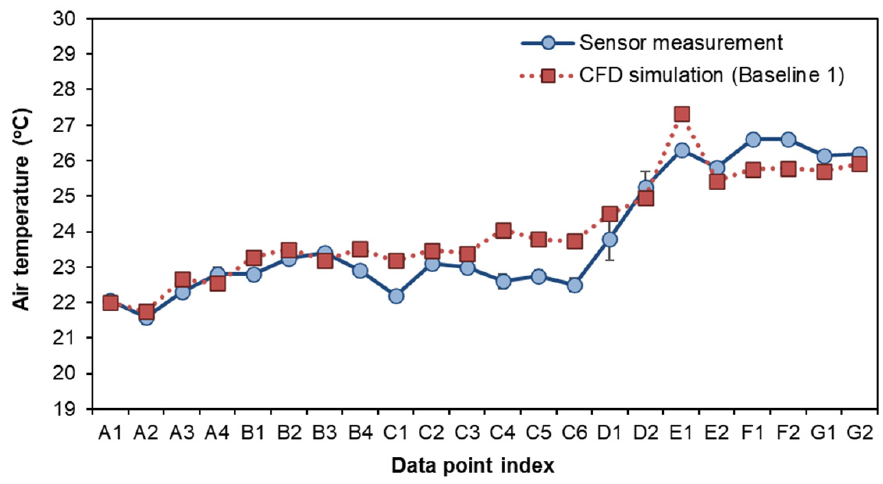
Figure 7. Comparison of indoor temperature from simulation and field measurement. As compared to the sensor measurement, the simulation slightly overestimates air velocity in the living room. The differences between the measured and simulated values are generally less than 0.1 m/s in air velocity for 18 out of 22 data points. As for air temperature, there is less than a 5% difference between measured and simulated values for 21 out of 22 data points. The indoor airflow is characterized by its very low velocity (<0.5 m/s) but a large fluctuation. The simulated results are higher in the living room and kitchen, but lower in the toilet. In particular, a greater error variation can be observed at the direct downflow and the circulated flow of air conditioning devices (such as A2, B1, B4, C3, C4, and C6). As compared to airflow rate, temperature distribution remains more stable. The field measurement is used to verify the simulated results. Since more than 80% of the simulated values have a small discrepancy with the measured data, the CFD results used in this study are considered acceptable for training the data-driven